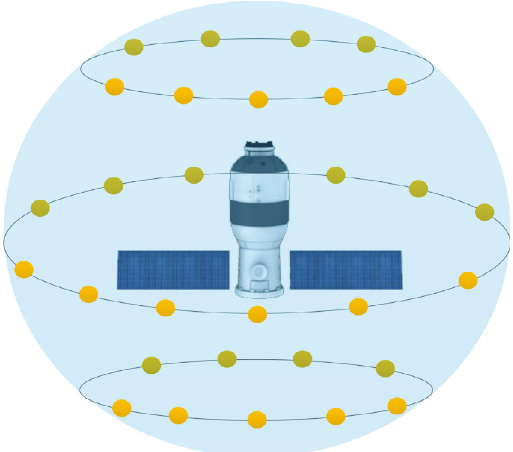
Figure 5: Illustration of the pose space discretization using the sphere with uniformly distributed camera locations. Every orange circle in the fi gure indicates the location of one